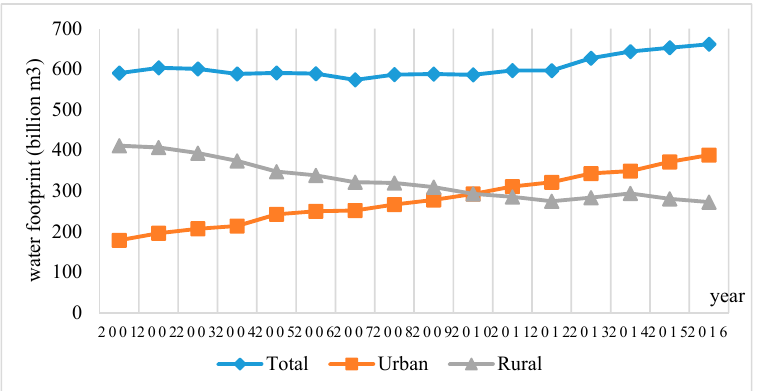
Figure 2. The trend of the water footprint of food consumption.